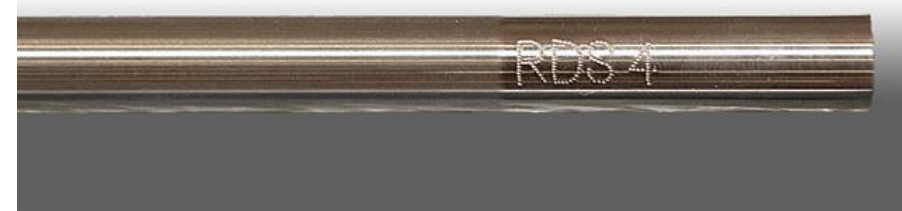
Figure 2. Sample photo of Mayer rod.